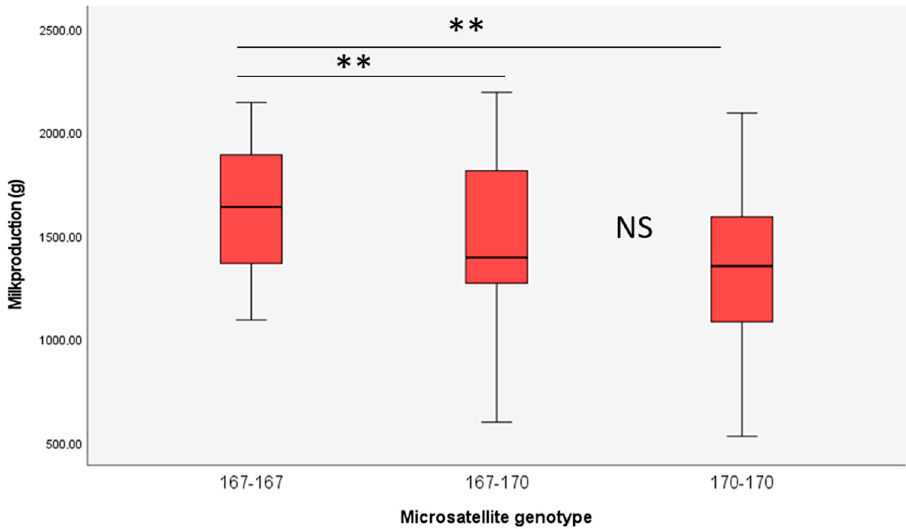
Figure 2. Distribution of milk production in groups of mothers with different microsatellite genotypes. 167/167 and 170/170 indicate the fragment lengths of the two homozygous genotypes, 167/170 indicates the fragment lengths of the heterozygous genotype (** indicates significant difference at p < 0.01